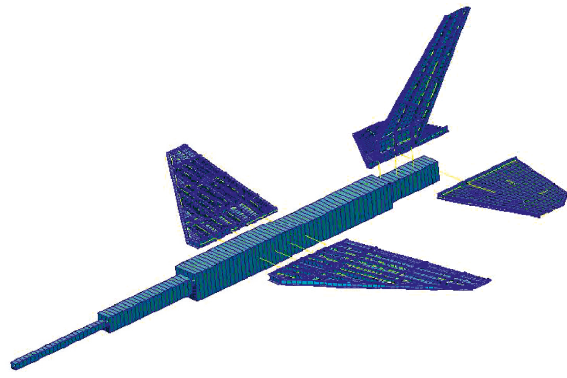
Figure 2: Equivalent FE model of F-16. Table 1: Modal parameters calculated using the equivalent FE